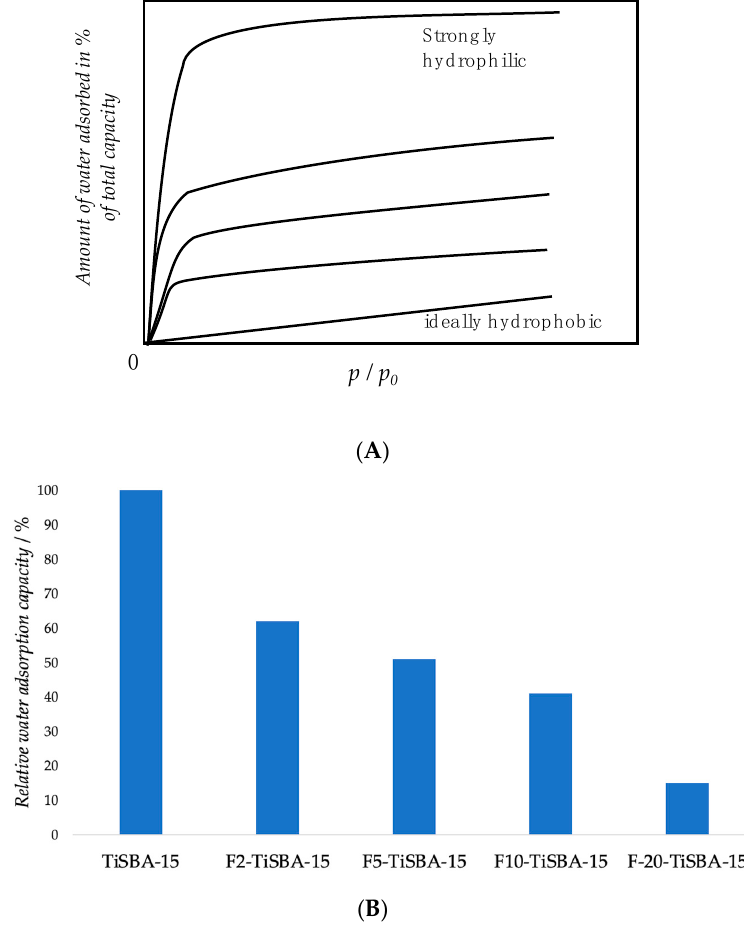
Figure 6. ( A ) Example of idealized water adsorption isotherms in the case of zeolitic materials. Adapted from Reference [54]. ( B ) Water adsorption capacity for TiSBA-15, F2-TiSBA-15, F5-TiSBA-15, F10-TiSBA-15 and F20-TiSBA-15 measured at 298 K [53]. Table 6. Relative water adsorption capacity compared to TEFS loading on TiSBA-15 at P/P 0 = 0.6 [53].